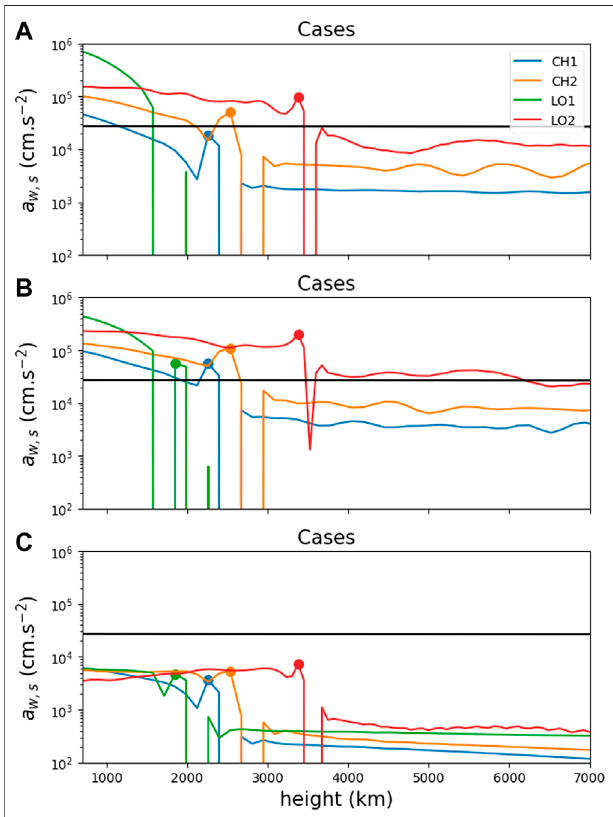
FIGURE 4 | Ponderomotive acceleration for all cases of Table 1 in the chromosphere and transition region. Top panel corresponds to cases (A) , middle panel to cases (B) , with a higher input δ v ⊙ , and bottom panel to cases (C) , with a lower amplitude and higher injection scale. The Sun ’ s gravity pull is shown in black. The colored dots indicates the position of the transition region in the pro fi les. They are usually associated with a peak in the ponderomotive acceleration.